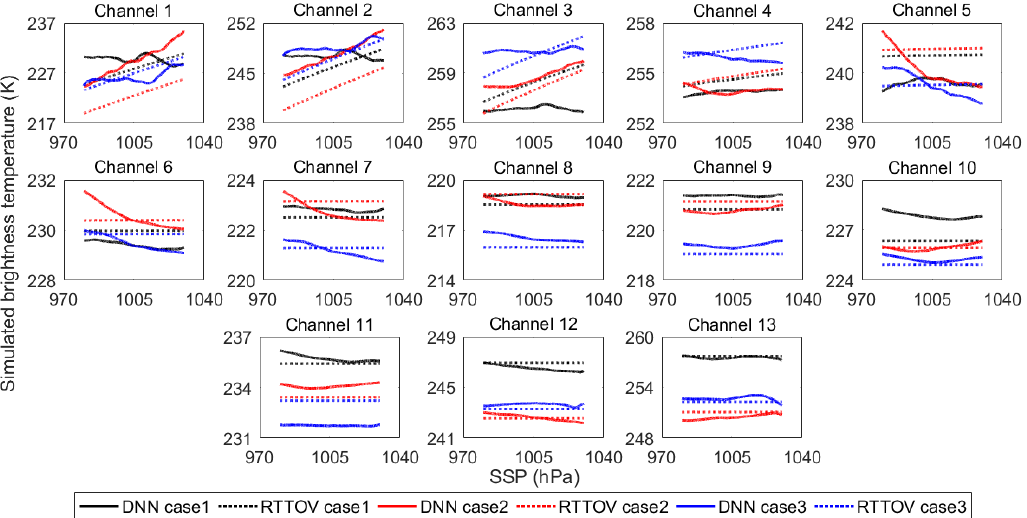
Figure 6. The sensitivity test results of MWTS-II to SSP based on the DNN-based and RTTOV-based simulated brightness temperatures.